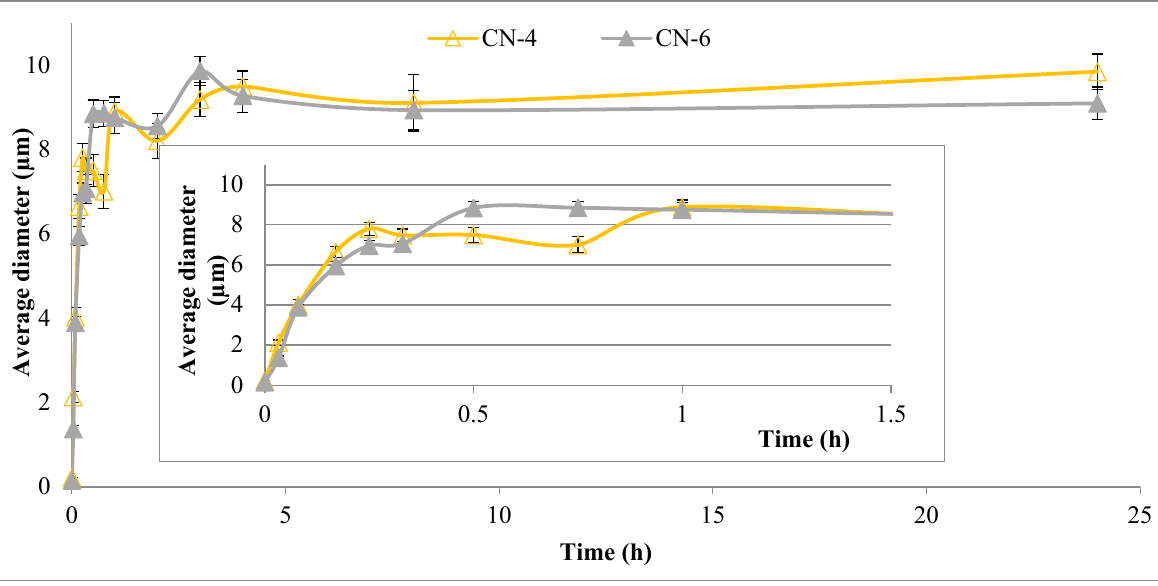
Table 4. Drug encapsulation efficiency values. Sample Code Encapsulated Drug g/g NCs